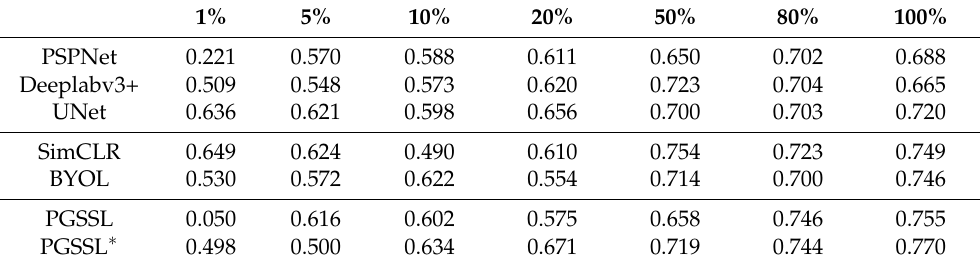
Table 4. Experimental effects of various methods on BJ dataset with different